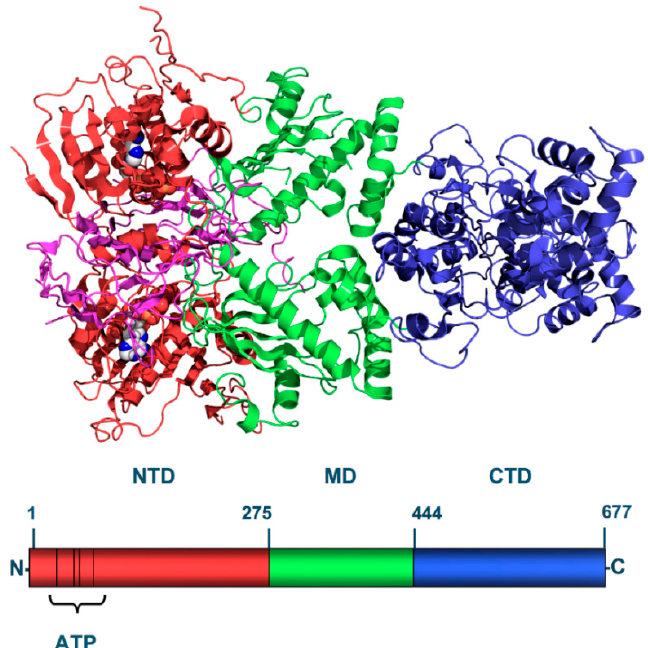
Figure 2. Primary structure of the yeast HSP90. The N-Terminal-Domain (NTD-red) is a highly conserved domain among HSPs and contains the ATP-binding pocket, target of many HSP90 inhibitors. The Middle-Domain (MD-green) is divided into three regions (a 3-layer α – β – α sandwich, a 3-turn α -helix and irregular loops and a 6-turn α -helix) and it is involved in client and substrate binding that increase ATPase activity (Aha1, Hch1). The C-terminal Domain (CTD-blue) possesses a moderate alternative ATP-binding site that become available when the N-terminal pocket is occupied.